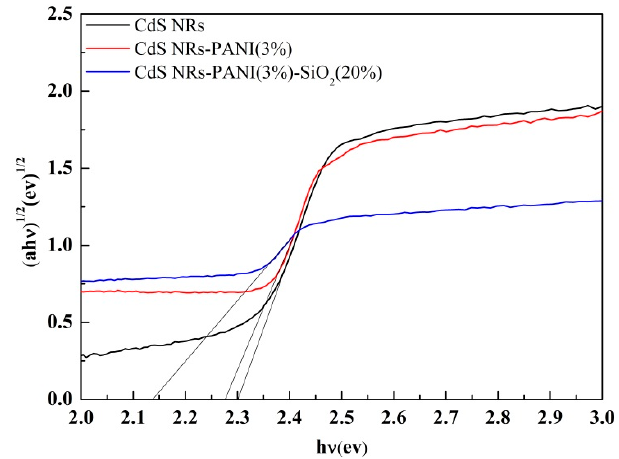
Figure 13. Kubelka–Munk conversion curve of CdS NRs, CdS NRs-PANI (3%), and CdS NRs-PANI (3%)-SiO 2 (20%).